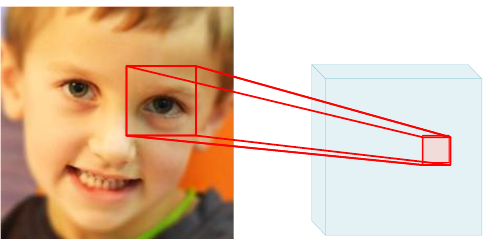
Figure 4. Mapping of the feature map and the raw image. On the coarse-grained feature map, each pixel contains 16 × 16 pixels of feature information in the raw image. Therefore, it is more efficient to crop the feature map, and it is easier to extract important overall feature